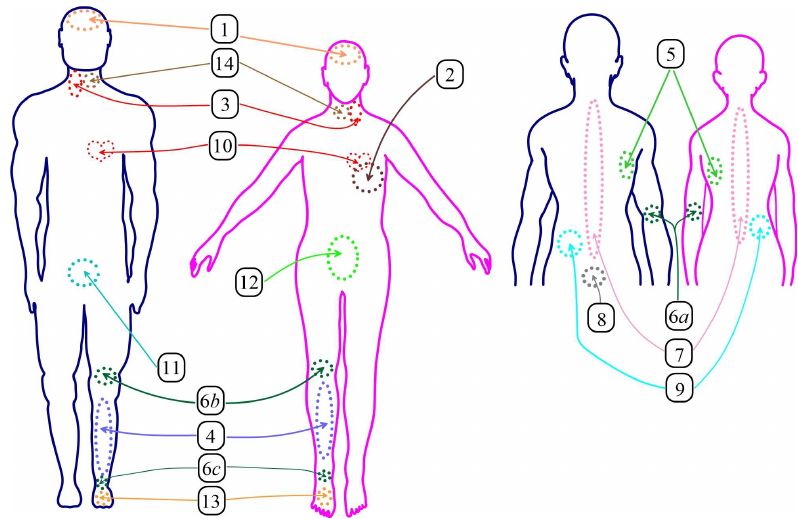
Figure 3. The MWR method has been successfully applied to the following organs, tissues, and